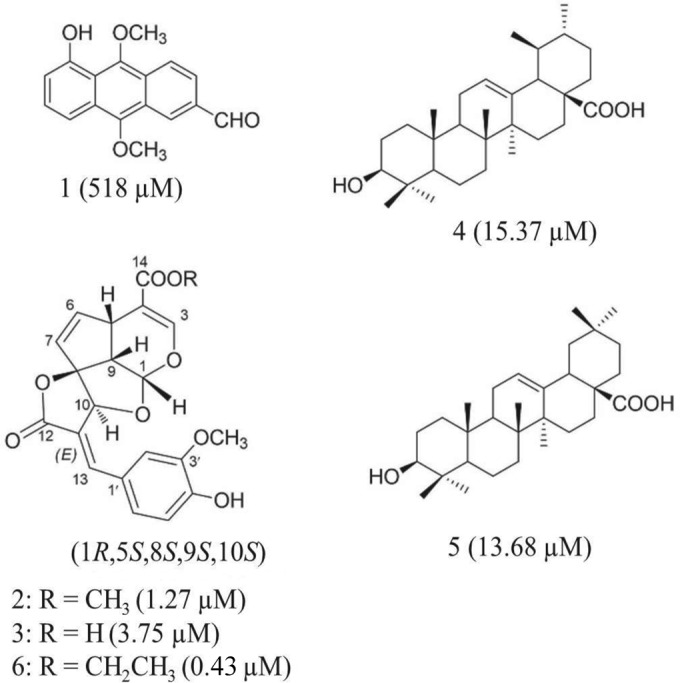
Chemical structures and activities of compounds isolated from M. lucida. Structures of novel tetracyclic spirolactone iridoids, ML-2-2, moludicin (compound 2), ML-2-3 (compound 3), and ML-F52 (compound 6), and known compounds, oruwalol (compound 1), ursolic acid (compound 4), and oleanolic acid (compound 5), isolated from Morinda lucida leaves with their respective IC50s after 48 h of incubation.